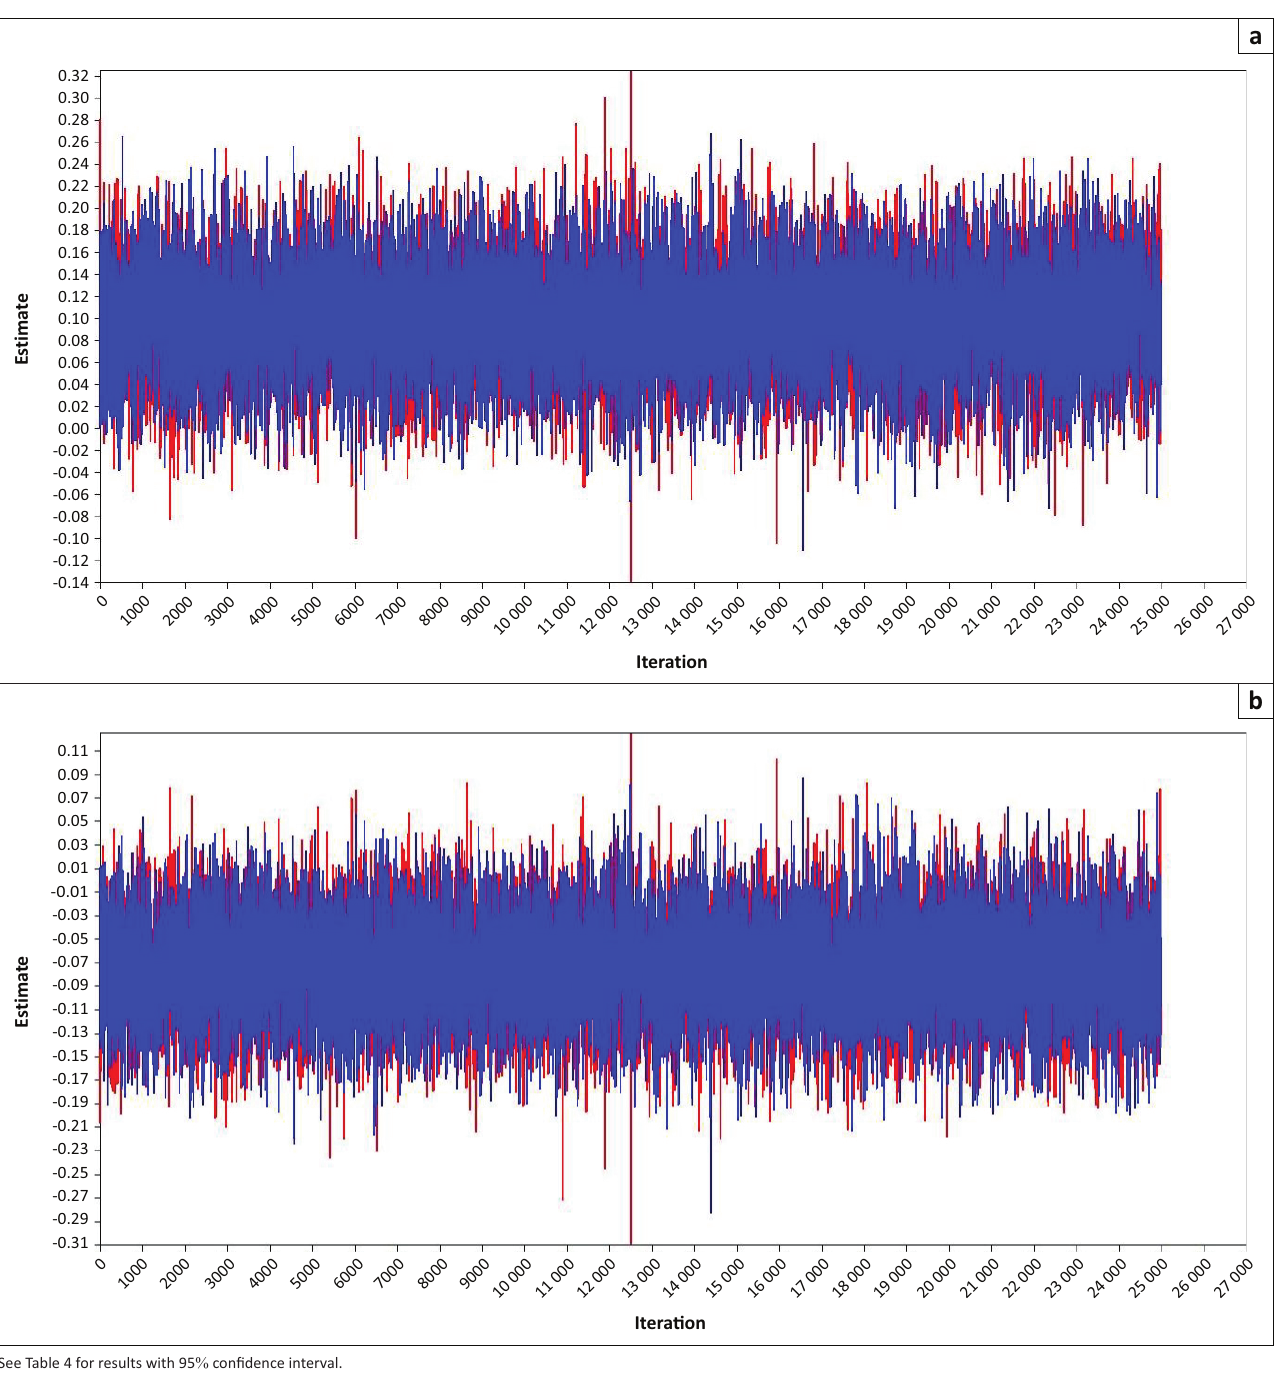
FIGURE 1: Plots for chain convergence and parameter distributions. Parameters: (a) Perceived organisational support for deficit correction (T1) predicting engagement (T2) and (b) perceived organisational support for strengths use (T1) predicting engagement (T2). Kernel density plots: (c) Perceived organisational support for deficit correction (T1) predicting engagement (T2) and (d) perceived organisational support for strengths use (T1) predicting engagement (T2).